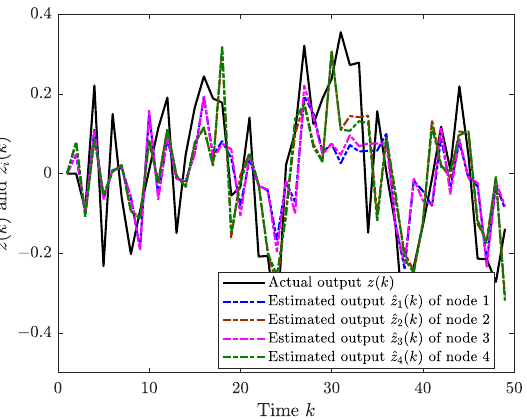
Figure 9. Evolution of system output z ( k ) and estimated output ˆ z i ( k ) in Case 3, i =